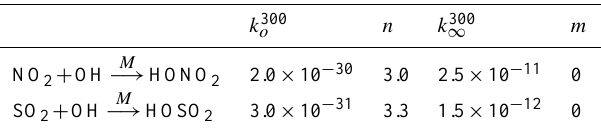
Table A1. Kinetic parameters used to determine the production rates of HNO 3 and H 2 SO 4 (JPL,